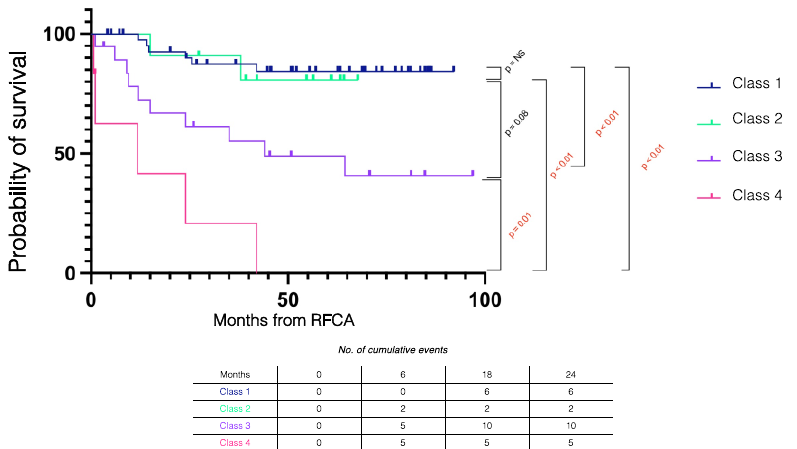
Figure 2. Kaplan–Meier survival curves stratified by procedural outcome in electrical storm patients. Figure 2. Kaplan – Meier survival curves stratified by procedural outcome in electrical storm pa- RFCA = radiofrequency catheter ablation. tients. RFCA = radiofrequency catheter ablation.